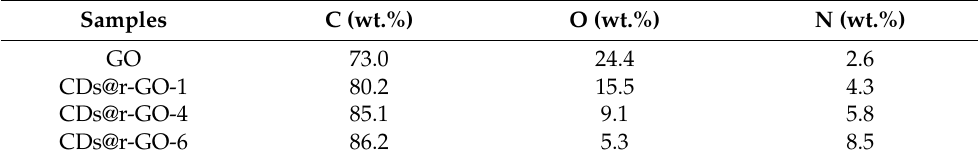
Table 1. Analysis of elemental contents obtained by XPS . Samples